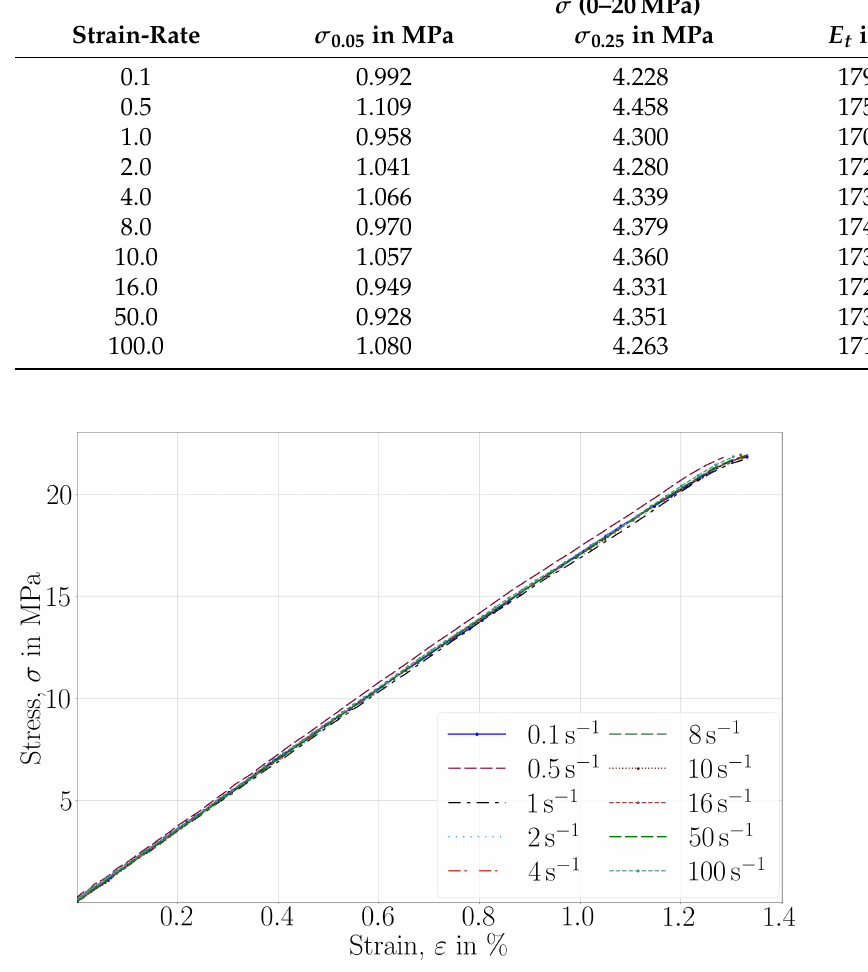
Figure 9. Stress-strain curves recorded in uniaxial tensile tests until